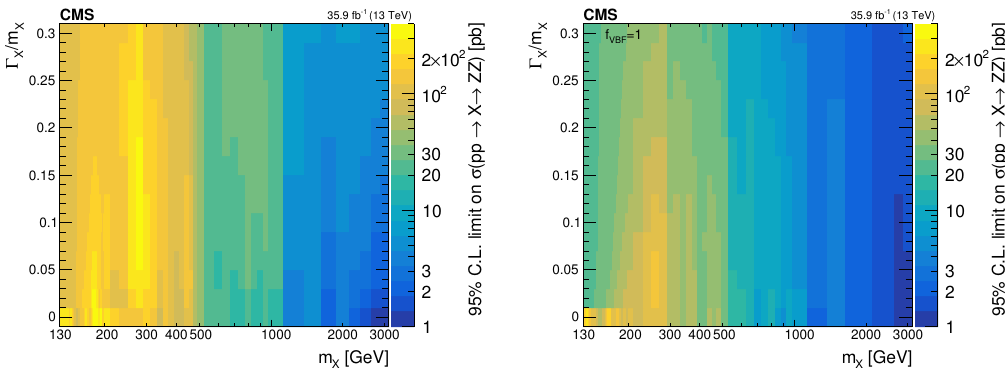
Figure 11 . Observed upper limits at the 95% CL on the pp ! X ! ZZ cross section as a function of m X and (cid:0) X =m X values with f VBF as a free parameter (left) and (cid:12)xed to 1 (right). The results are shown for the 4 ‘ , 2 ‘ 2q, and 2 ‘ 2 (cid:23) channels combined. The reported cross section corresponds to the signal only contribution in the absence of